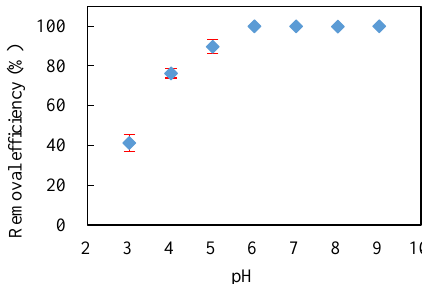
Figure 6. Effect of the solution pH on the adsorption of Pb 2+ by the as-prepared GO, C 0 = 150 mg/L, m/v = 0.3 g/L, t = 2 h, and T = 298 K.